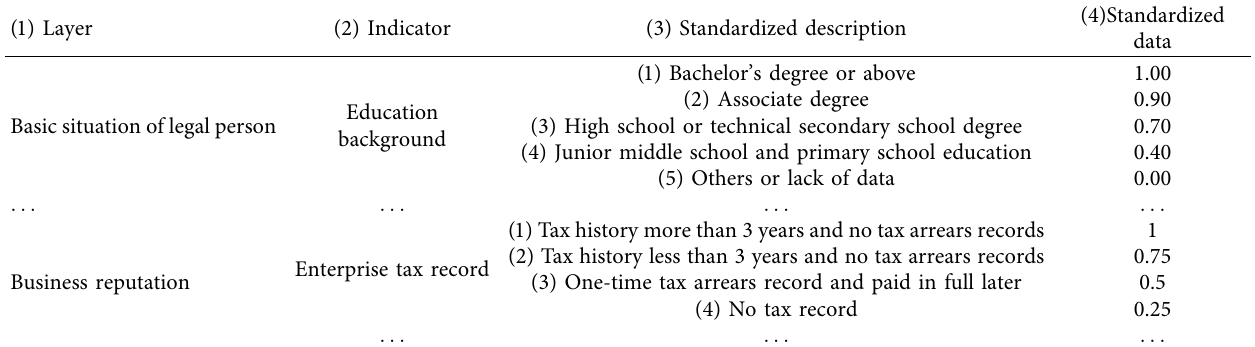
Table 1: The standard used for standardization of qualitative indicators.